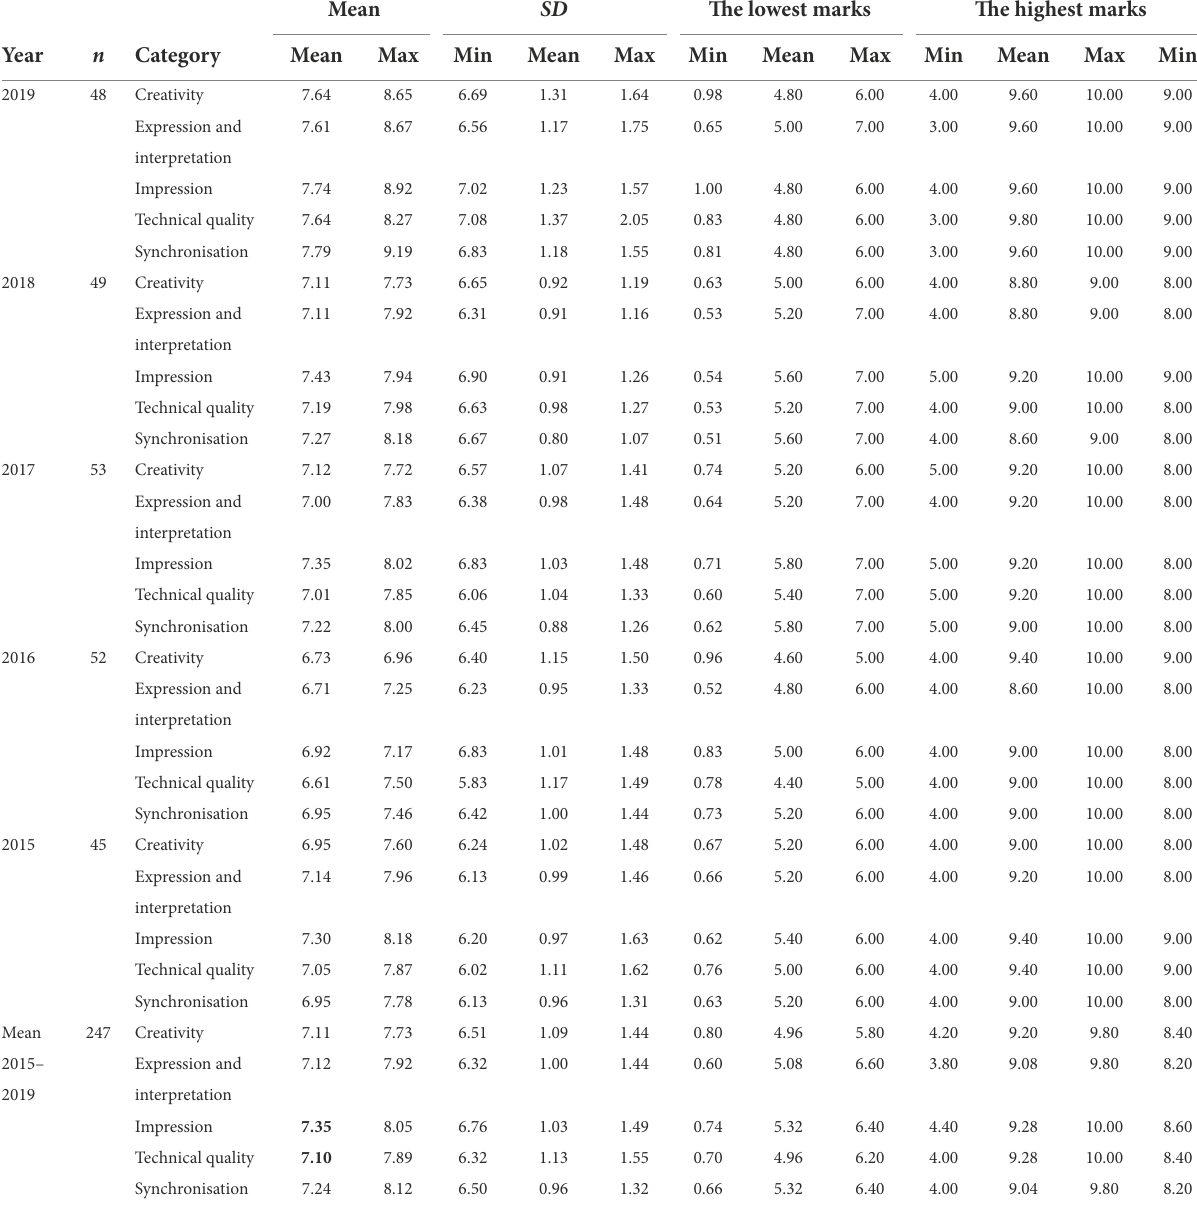
TABLE 3 Mean, minimum and maximum values for five categories and the final scores for the 2015–2019